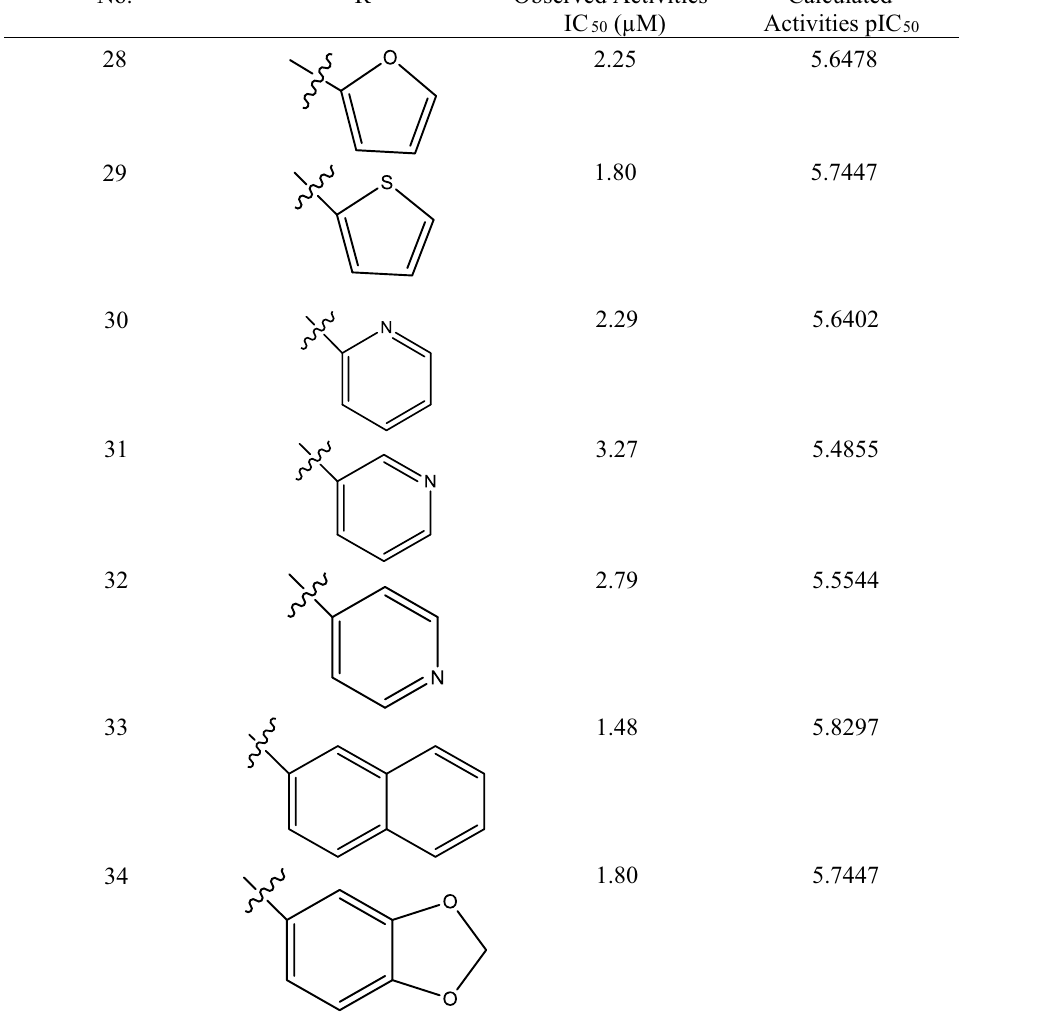
Table 2 The inhibitory activities of parthenolide derivatives for template molecule 2 No.